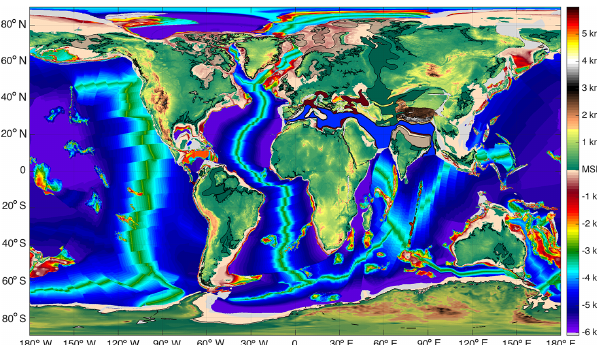
Figure 5. Reconstructed topography and bathymetry with spe- cific adjustments indicated by shaded areas, these include mainly Antarctica, southern Panama, the Amazon and several other river basins, the Hudson Bay and Great Lakes, Neotethyan Ocean and Paratethys Seaway, the Ninety-East Ridge and the Tasman